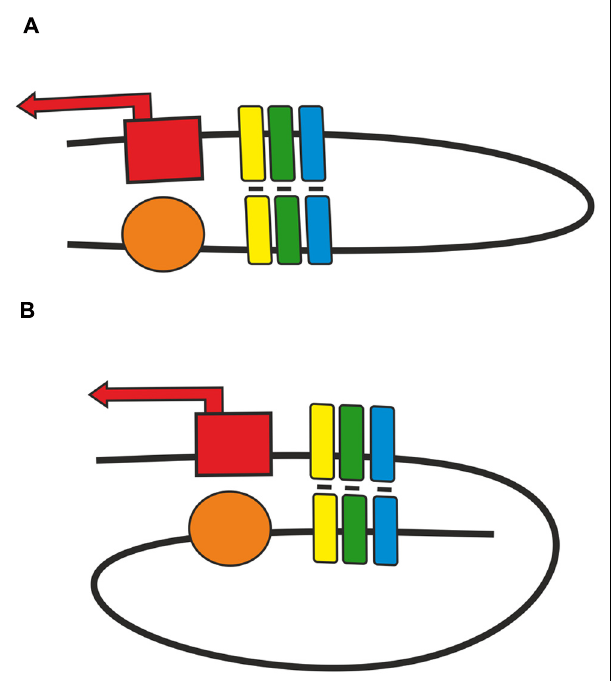
FIGURE 2 |Two modes of pairing between two copies of an insulator inserted in either (A) opposite or (B) same orientation. Presumptive proteins responsible for insulator pairing are shown as a cluster of yellow, green, blue boxes. Red box with solid arrow indicates promoter region, orange oval – enhancer